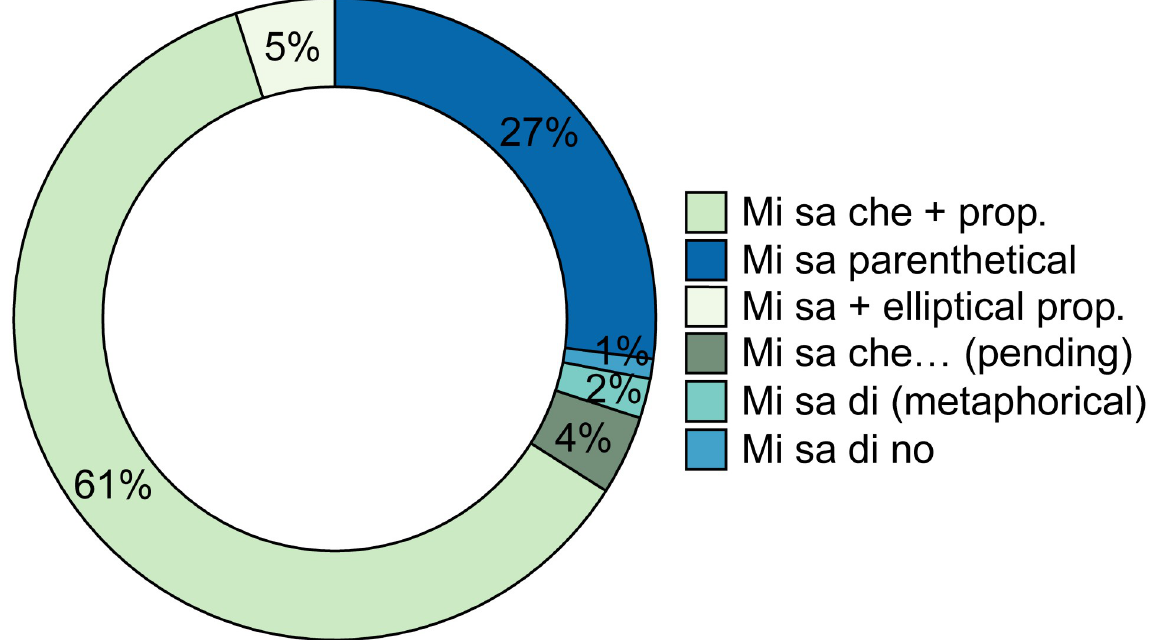
Fig 2. Percentages of the occurrences of mi sa in both modules (KIP +